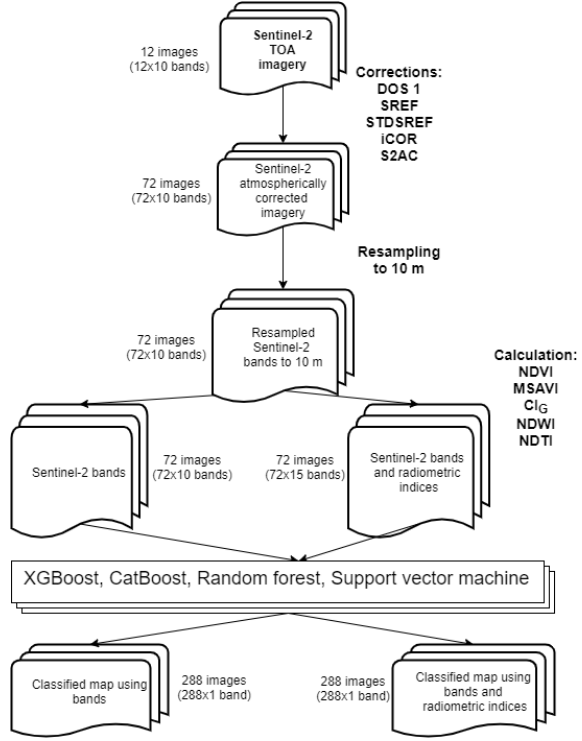
Figure 2. The workflow of processing Sentinel-2.